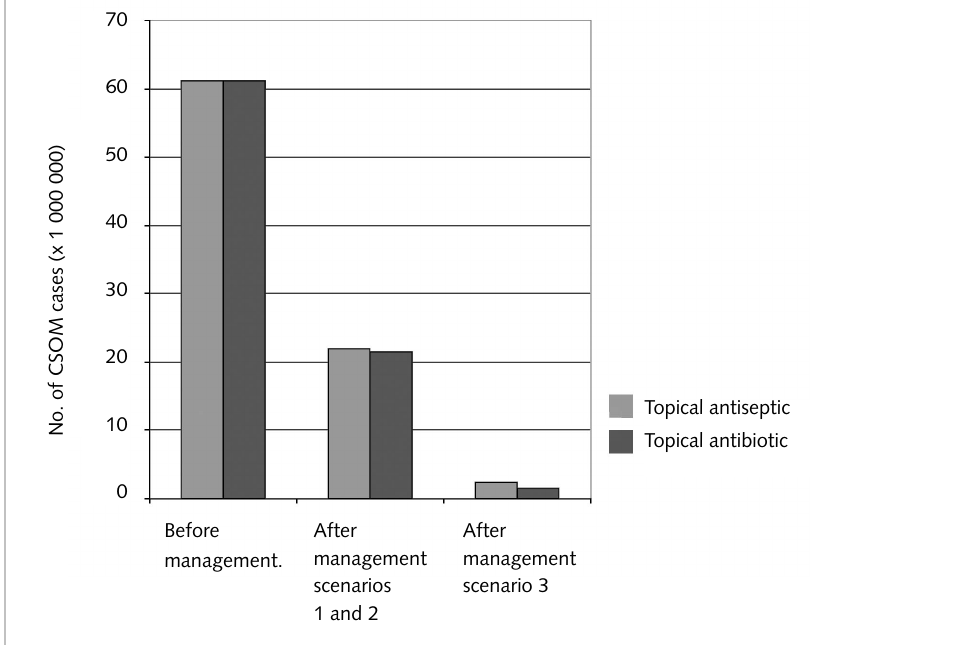
Fig. 5. Comparison of proportions of dry ears between topical antiseptic and topi- cal antibiotic treatments in management scenarios 1,2 and